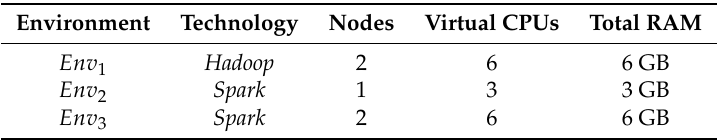
Table 2. Execution